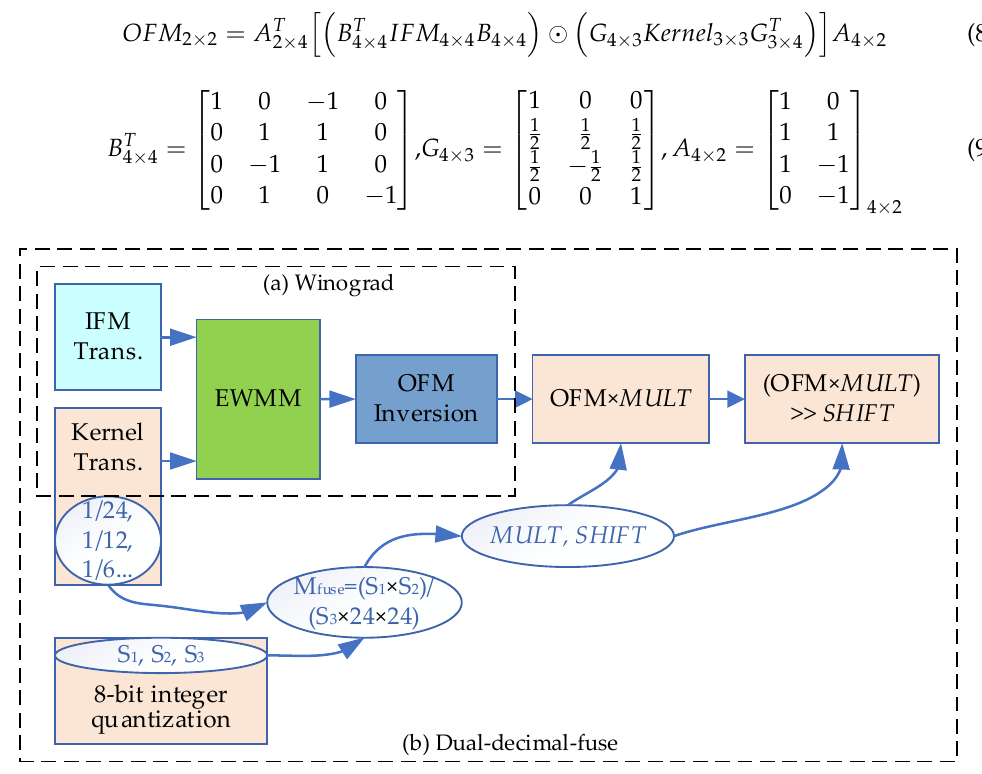
Figure 5. Fast Algorithm ( a ) Winograd ( b ) Dual-decimal-fuse. In Equation (9), there is 1/2 in the kernel transformation matrix ( G 4 × 3 ). Although it is not an integer, it can be converted to the right shift